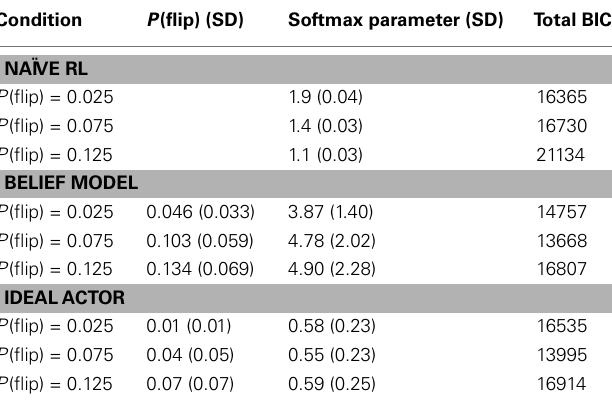
Table 1 | Best-fitting parameter values by model and condition.